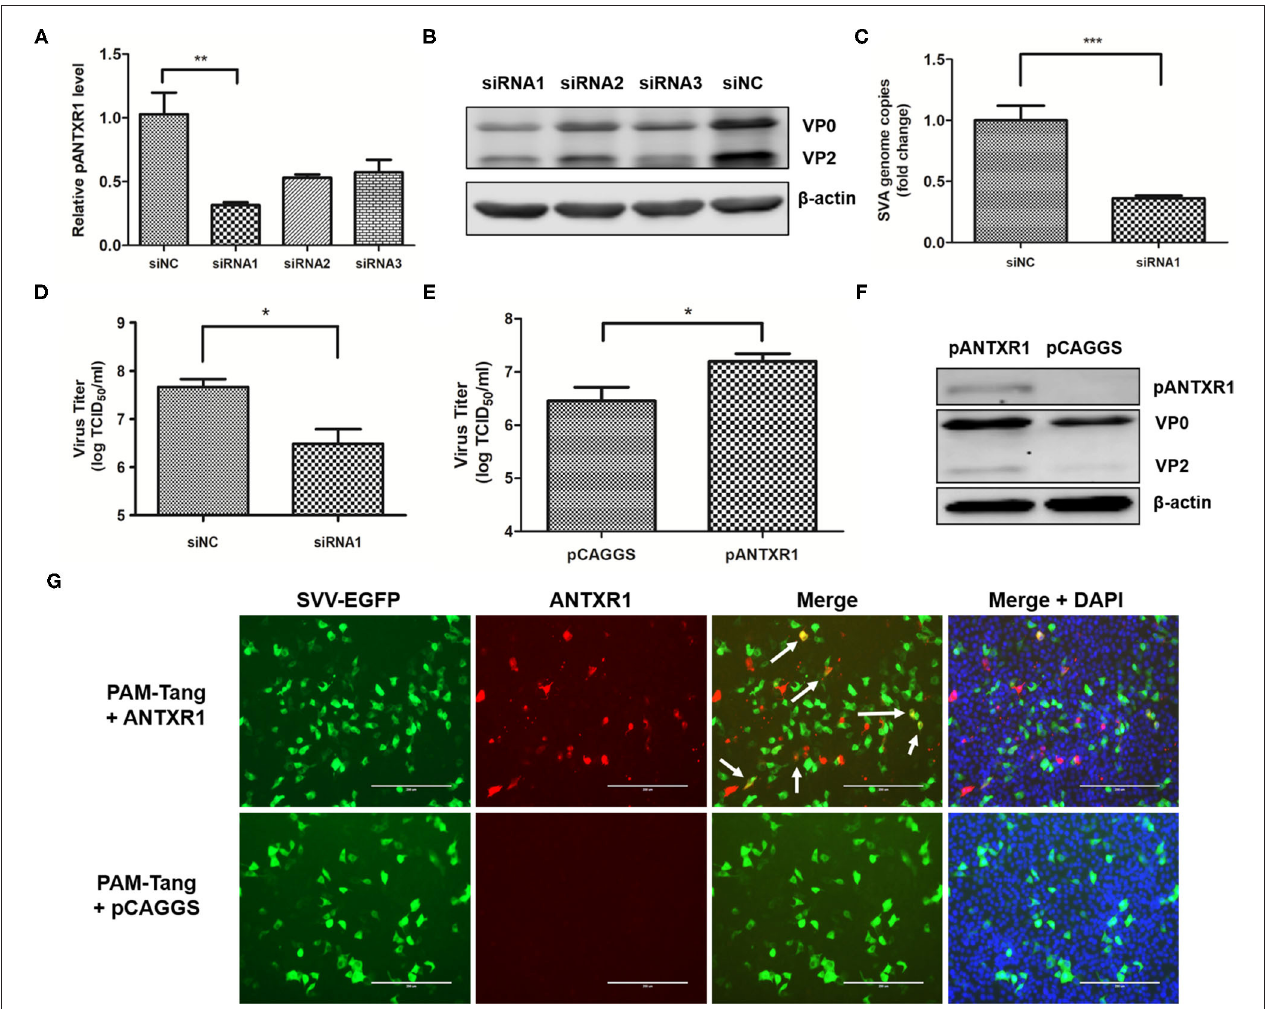
FIGURE 2 | pANTXR1 interference reduced SVA replication in PAM-Tang cells. The SVA at an MOI of 0.1 was added to the PAM-Tang cells after siRNA interference. (A) The qPCR analysis of relative pANTXR1 mRNA levels changes in PAM-Tang cells (** p < 0.01). (B) The Western blot assay for the expression of SVA VP2 and VP0 proteins. (C) The qPCR analysis of SVA copy numbers in the supernatant (*** p < 0.001). (D) The TCID 50 assay for SVA titers in supernatants post siRNA1 interference (* p < 0.05). (E) The TCID 50 assay for SVA titers in pANTXR1 overexpressed PAM-Tang cells at 6 hpi (* p < 0.05). (F) The western blot assay for the expression of SVA VP2, VP0 proteins and pANTXR1 from pANTXR1 overexpressed PAM-Tang cells at 6 hpi. (G) Immunofluorescent assay for pANTXR1 (in red) and EGFP (in green) expression level in the pANTXR1 overexpressed PAM-Tang cells, and the colocalization of pANTXR1 with EGFP was indicated by arrow. Bars, 200 µ